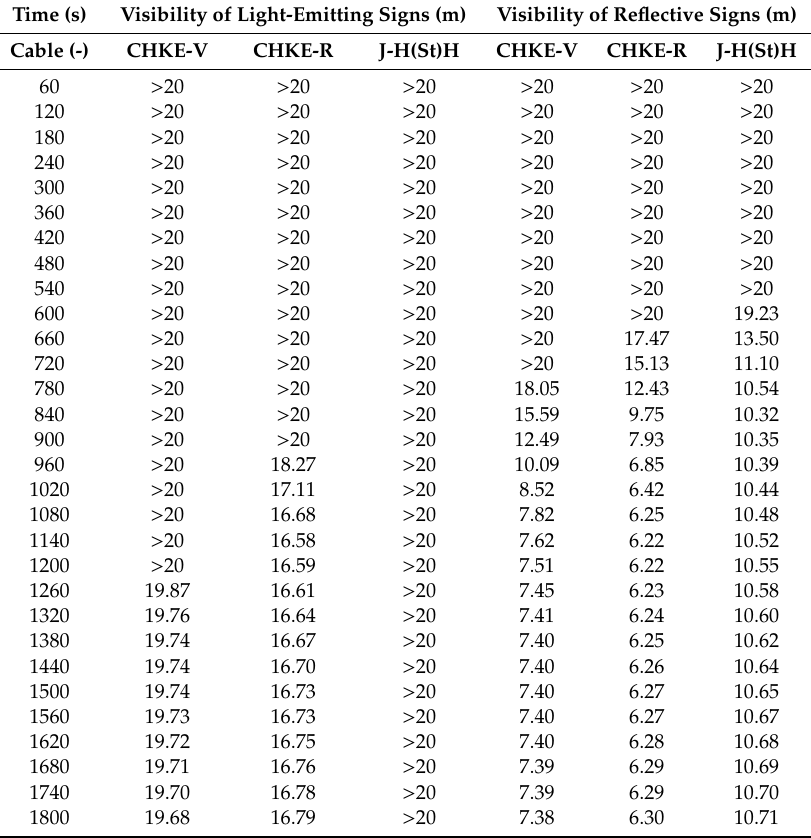
Table 6. Light-emitting and reflective signs visibilities for selected fire